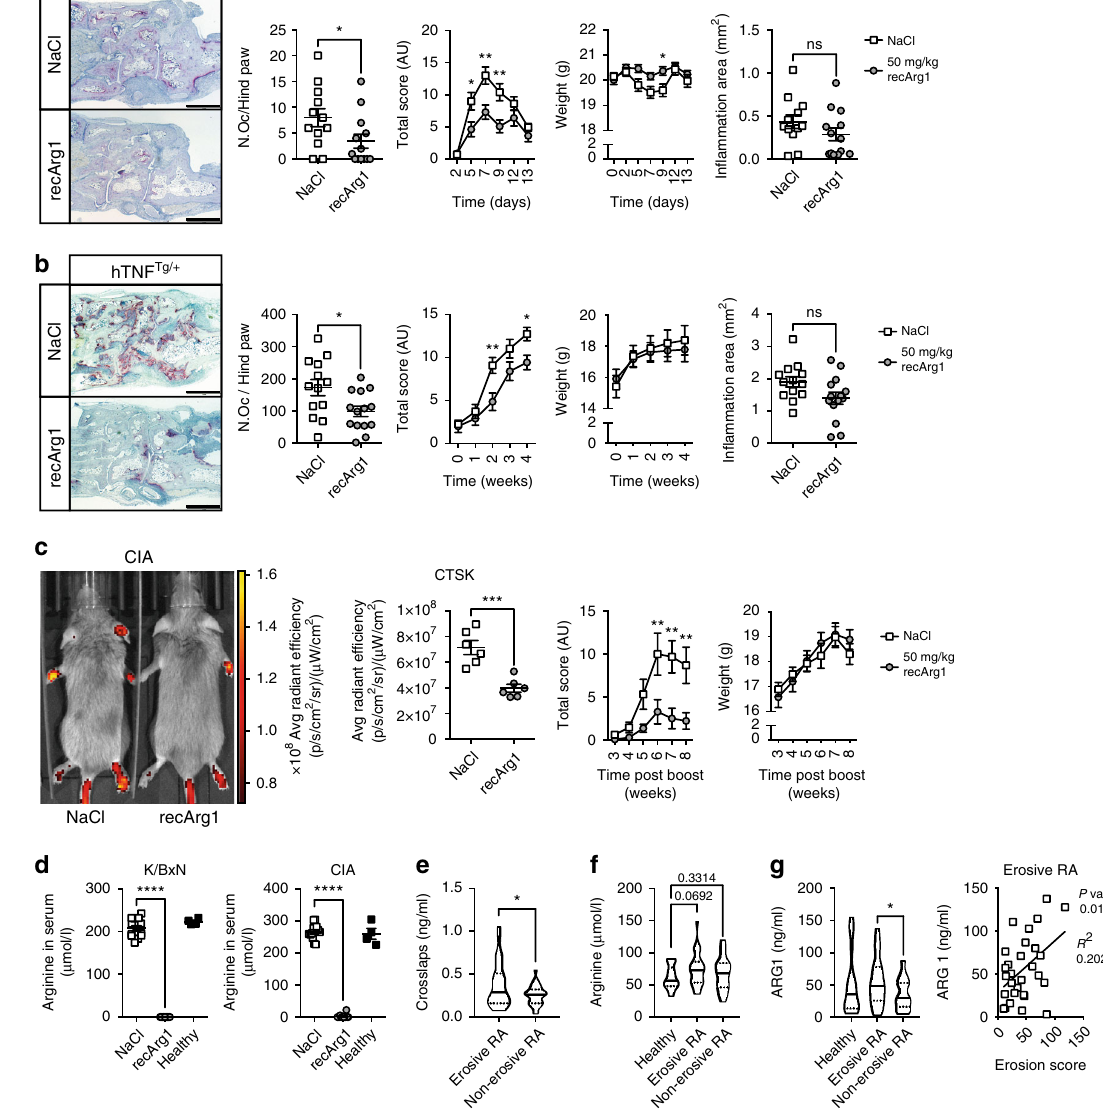
Fig. 1 Recombinant arginase 1 (recArg1) improves outcome in diverse murine arthritis models and arginase 1 is elevated in erosive RA patients. a , b Paw histology, osteoclast numbers per hind paw (N. Oc), total scores, weight and histology in fl ammation area of mice suffering from serum transfer arthritis ( a K/BxN, NaCl n = 12, recArg1 n = 13 animals) or the hTNF tg/ + mouse model ( b NaCl n = 13, recArg1 n = 14 animals). Scale bar represents 1 mm. c Ctsk IVIS and quanti fi cation, total scores and weights of mice suffering from collagen-induced arthritis (CIA, NaCl n = 13, recArg1 n = 14 animals, Ctsk IVIS n = 6 animals). d RecArg1 depletes serum arginine; K/BxN ( n = 13 animals per group), CIA (NaCl n = 13, recArg1 n = 14 animals). NaCl in a – d represents saline vehicle control group. e Serum crosslaps in the indicated patient groups (erosive RA n = 30, non-erosive RA n = 29 patients). f Serum arginine levels of all patient groups (healthy n = 19, erosive RA n = 29, non-erosive RA n = 30 patients). g Arginase 1 levels in all patient groups and correlation between arginase 1 and erosion score of patients suffering from erosive RA (healthy n = 19, erosive RA n = 29, non-erosive RA n = 30 patients). Data are mean ± SEM, * P < 0.05, ** P < 0.01, *** P < 0.001, **** P < 0.0001, unpaired t -test ( a – c , e – g ), one-way ANOVA ( d ) and two-way ANOVA post-hoc pairwise comparisons with Bonferroni correction ( a – c ), linear regression ( g ). Source data are provided as a Source Data fi